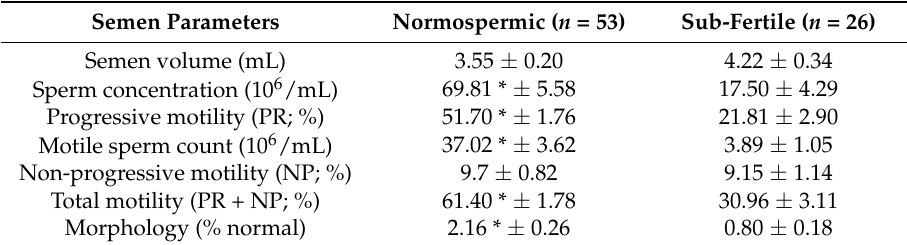
Table 1. Semen parameters of normospermic and sub-fertile patients.